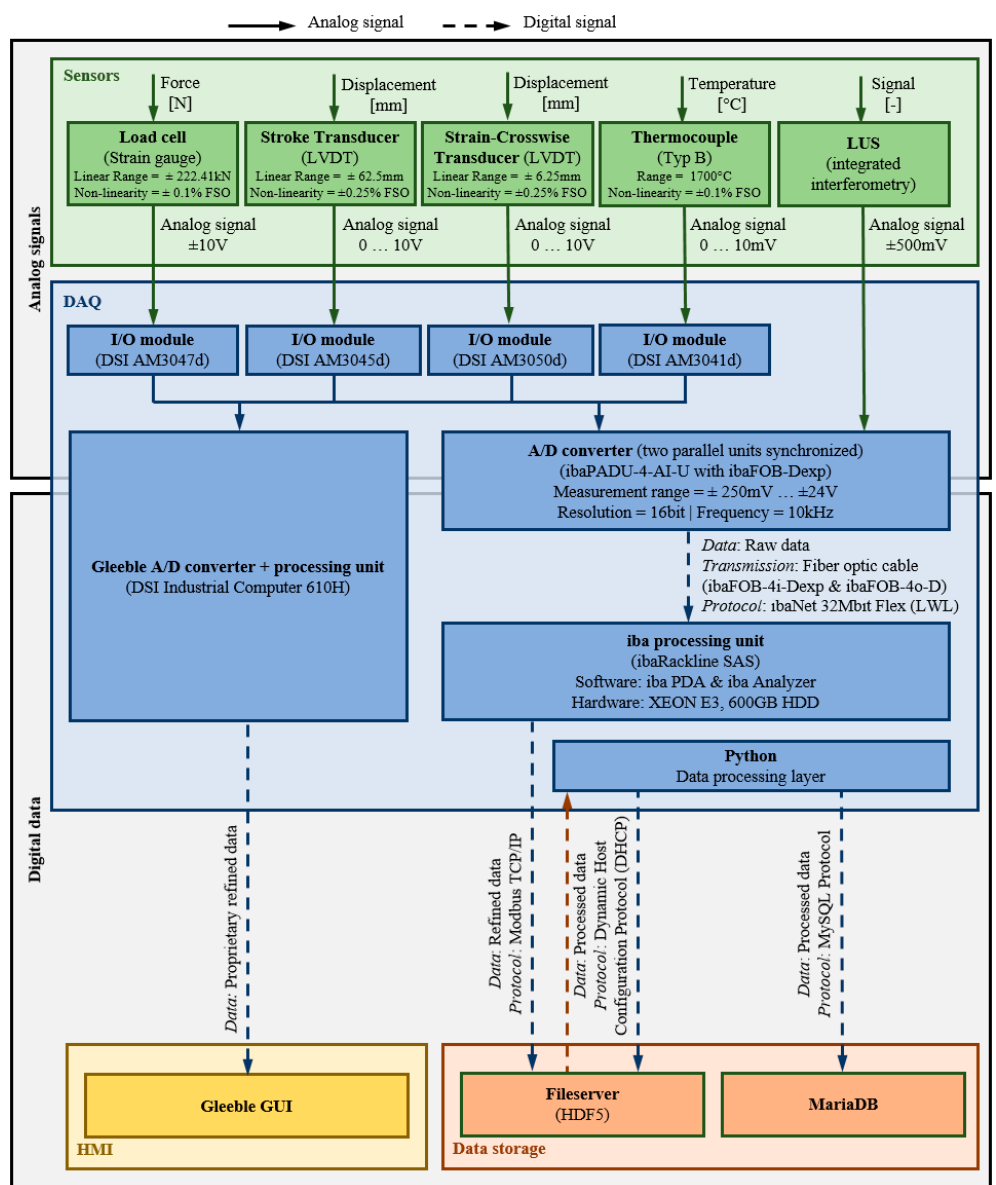
Figure 3. Visualization of the DAQ and data storage method.